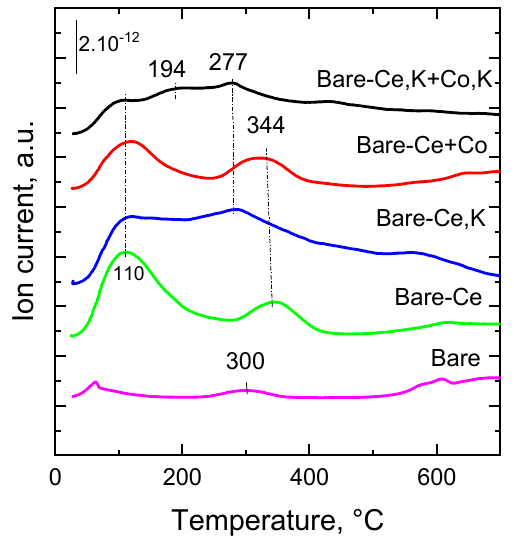
Figure 5. CO 2 -TPD profiles obtained for the prepared catalysts.